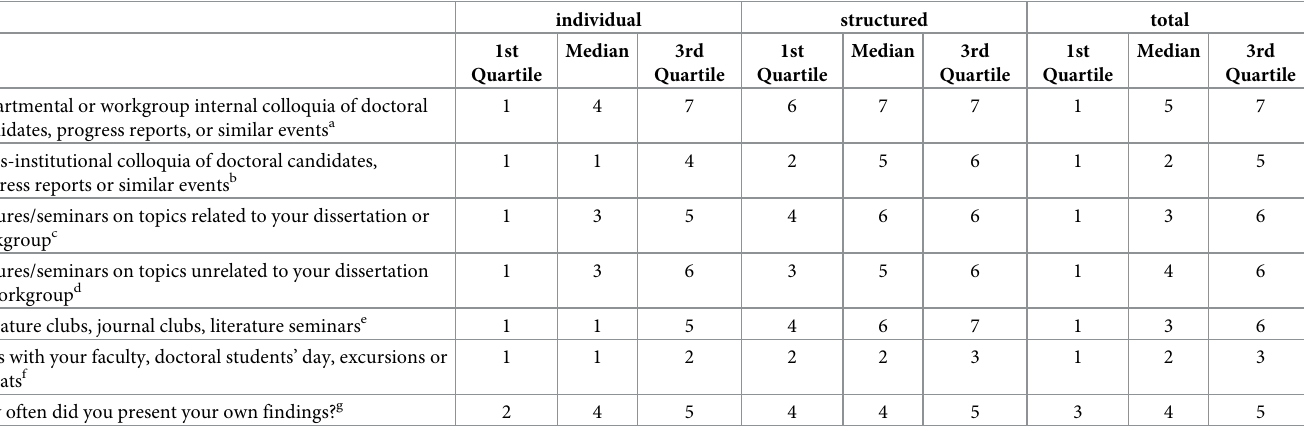
Table 9. Formal learning—regular learning formats.